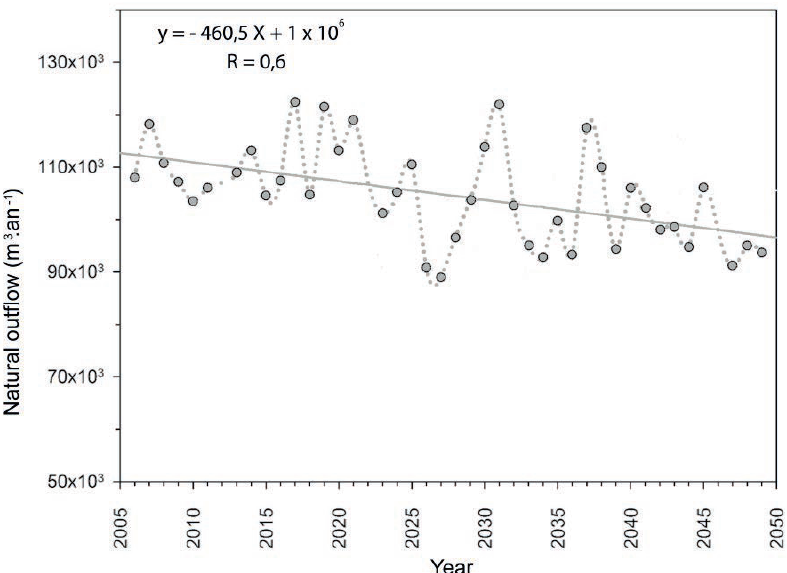
Fig. 4 Natural annual outflows simulated between 2005 and